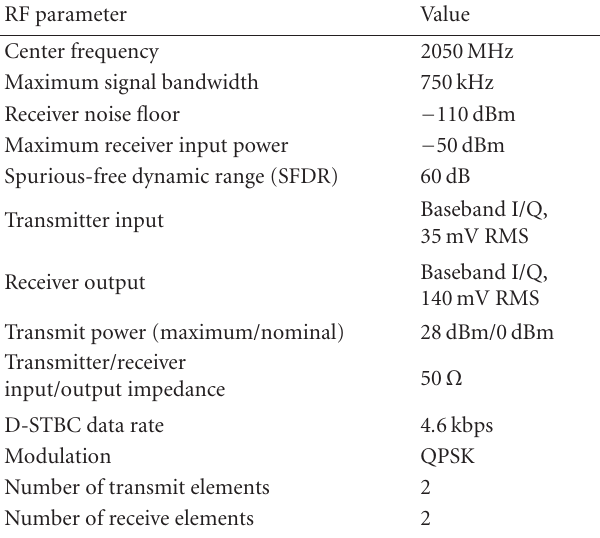
Figure 1: System architecture overview. Table 1: Key parameters of the